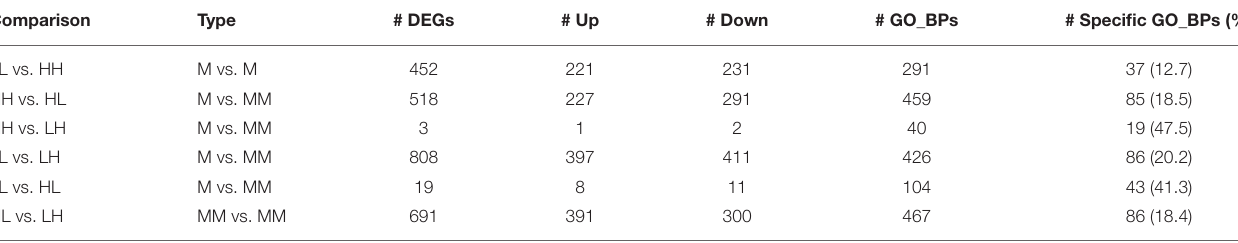
TABLE 2 | Summary of results from the differential expression and functional enrichment